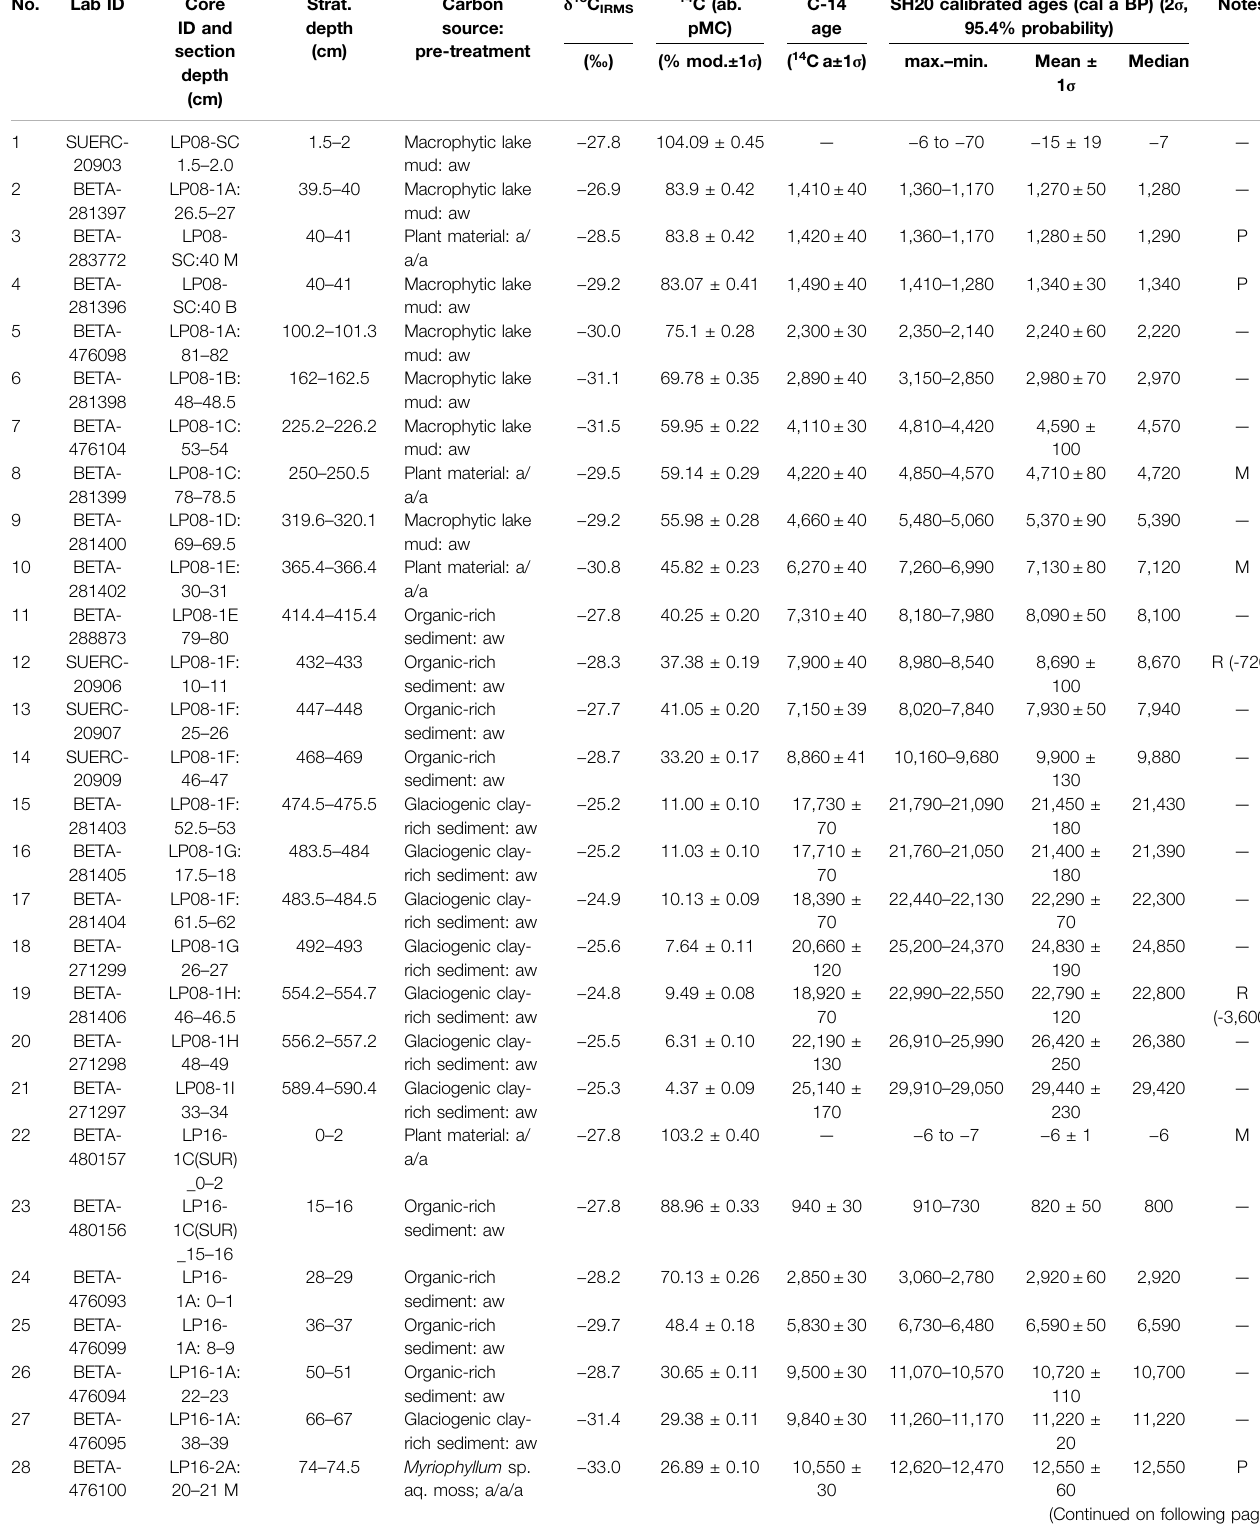
TABLE 3 | Radiocarbon dating data for the LP08 and LP16 records. Aw, acid wash; a/a/a, acid-alkali-acid pre-treatment; M, macrofossil age; P, paired bulk-macrofossil ages; R,age reversal andlengthofreversalinyears inbrackets. Reasonsfor rejection: X-a,organic sediments emplacedon extraction; X-b,drag down ofyoungerroots during